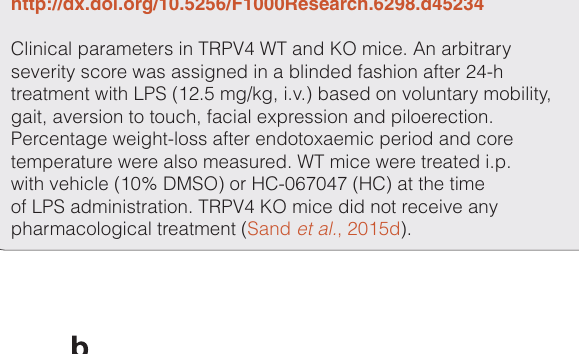
Dataset 3. Raw Data for Figure 4